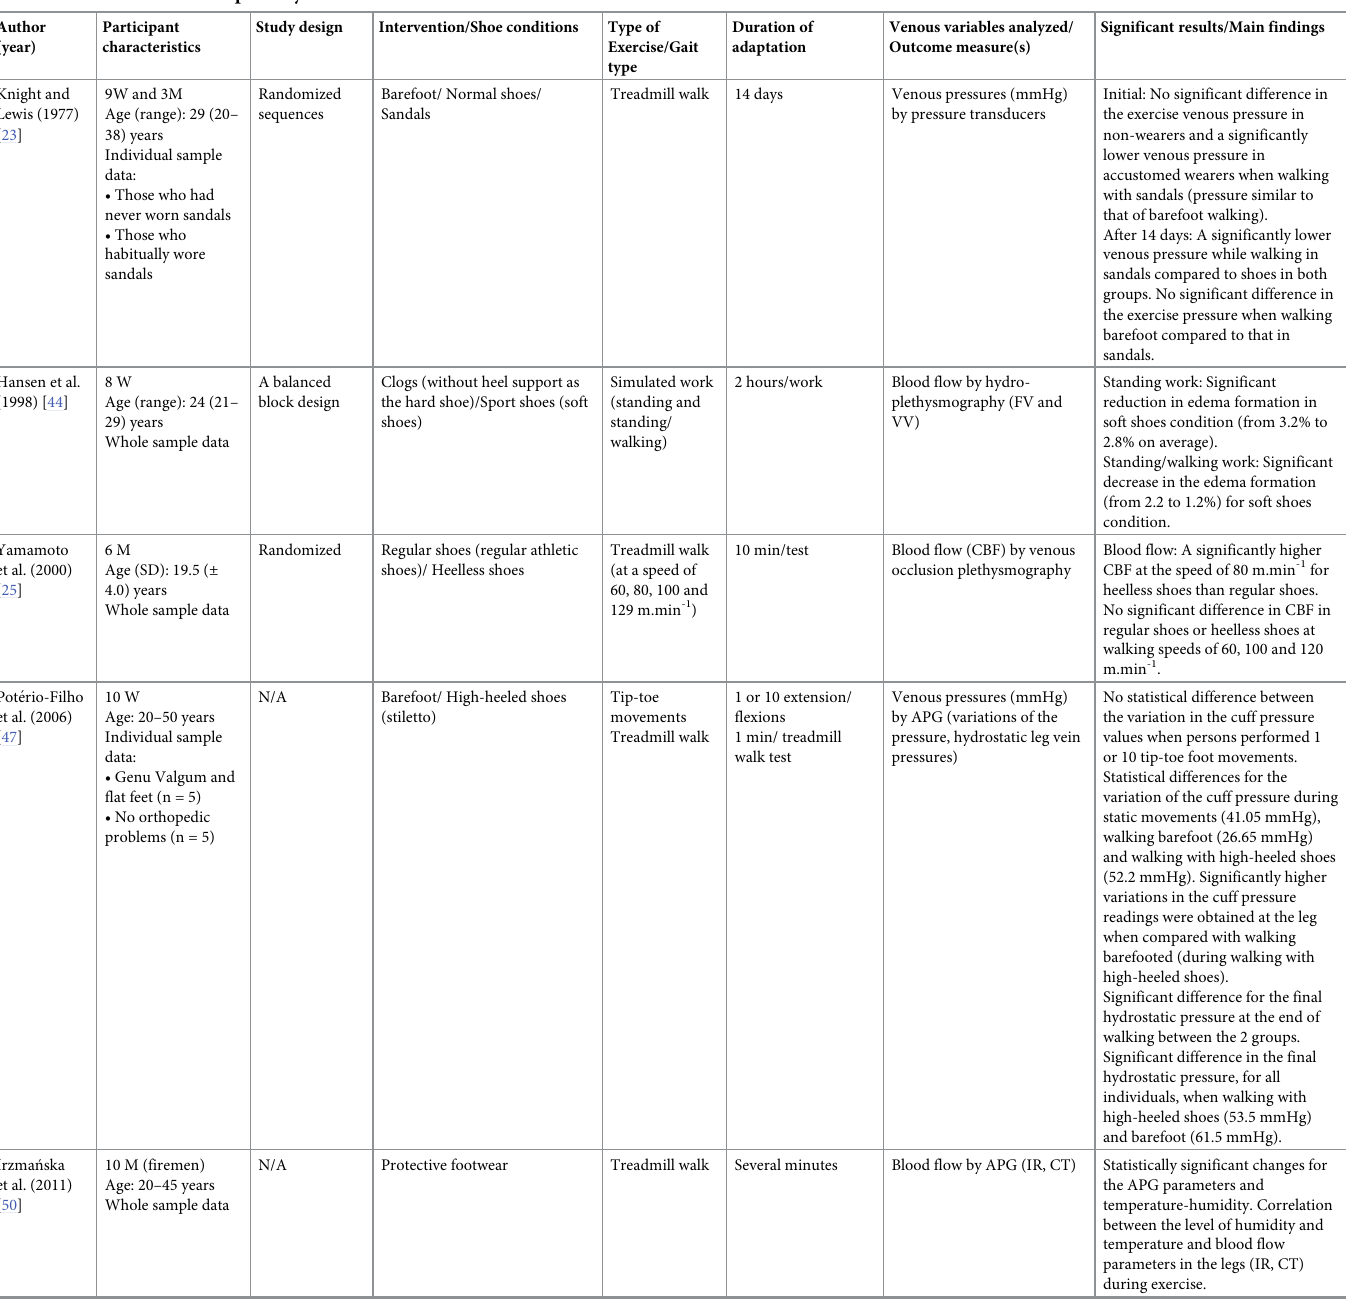
Table 2. Characteristics and primary outcomes of